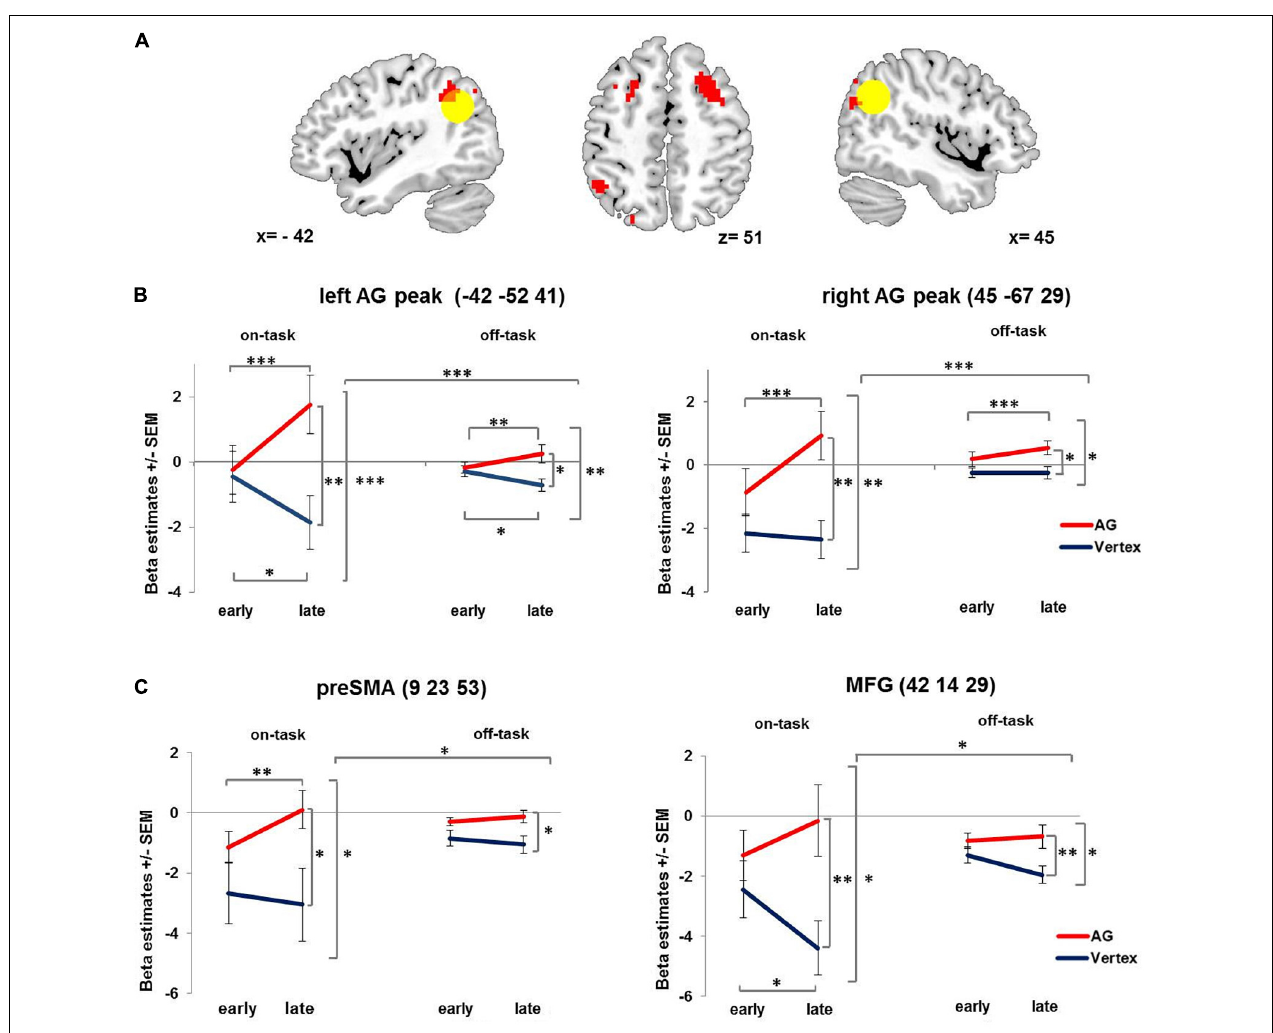
FIGURE 3 | Condition-related activation changes over time. (A) Brain regions showing increasing condition-related activity over time after 1 Hz rTMS applied to the right AG compared to vertex. Yellow circle denotes left and right angular gyrus ROIs (12 mm). For visualization purposes all images are thresholded at voxel level p = 0.001 uncorrected. (B) Interaction of stimulation × time × condition displayed at the left and right AG peak coordinates. (C) Interaction of stimulation × time × condition, displayed at preSMA and MFG peaks as identified for showing a compatibility effect. AG: angular gyrus. MFG: middle frontal gyrus. PreSMA: pre-supplementary motor area. SEM: standard error of the mean. ∗ denotes p < 0.05, ∗∗ denotes p < 0.01, ∗∗∗ denotes p <